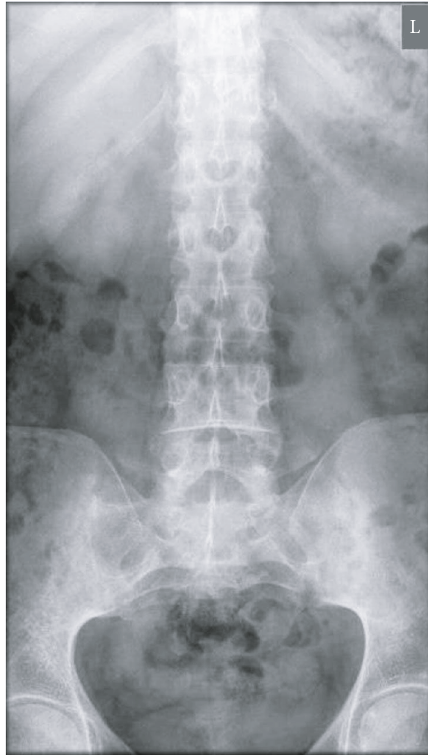
Figure 2: Plain fi lm radiograph of the patient. Anteroposterior plain- fi lm radiograph of the patient performed prior to his initial presentation. Signi fi cant sacroiliitis is seen with sclerosis and partial ankylosis of the sacroiliac joints demonstrated